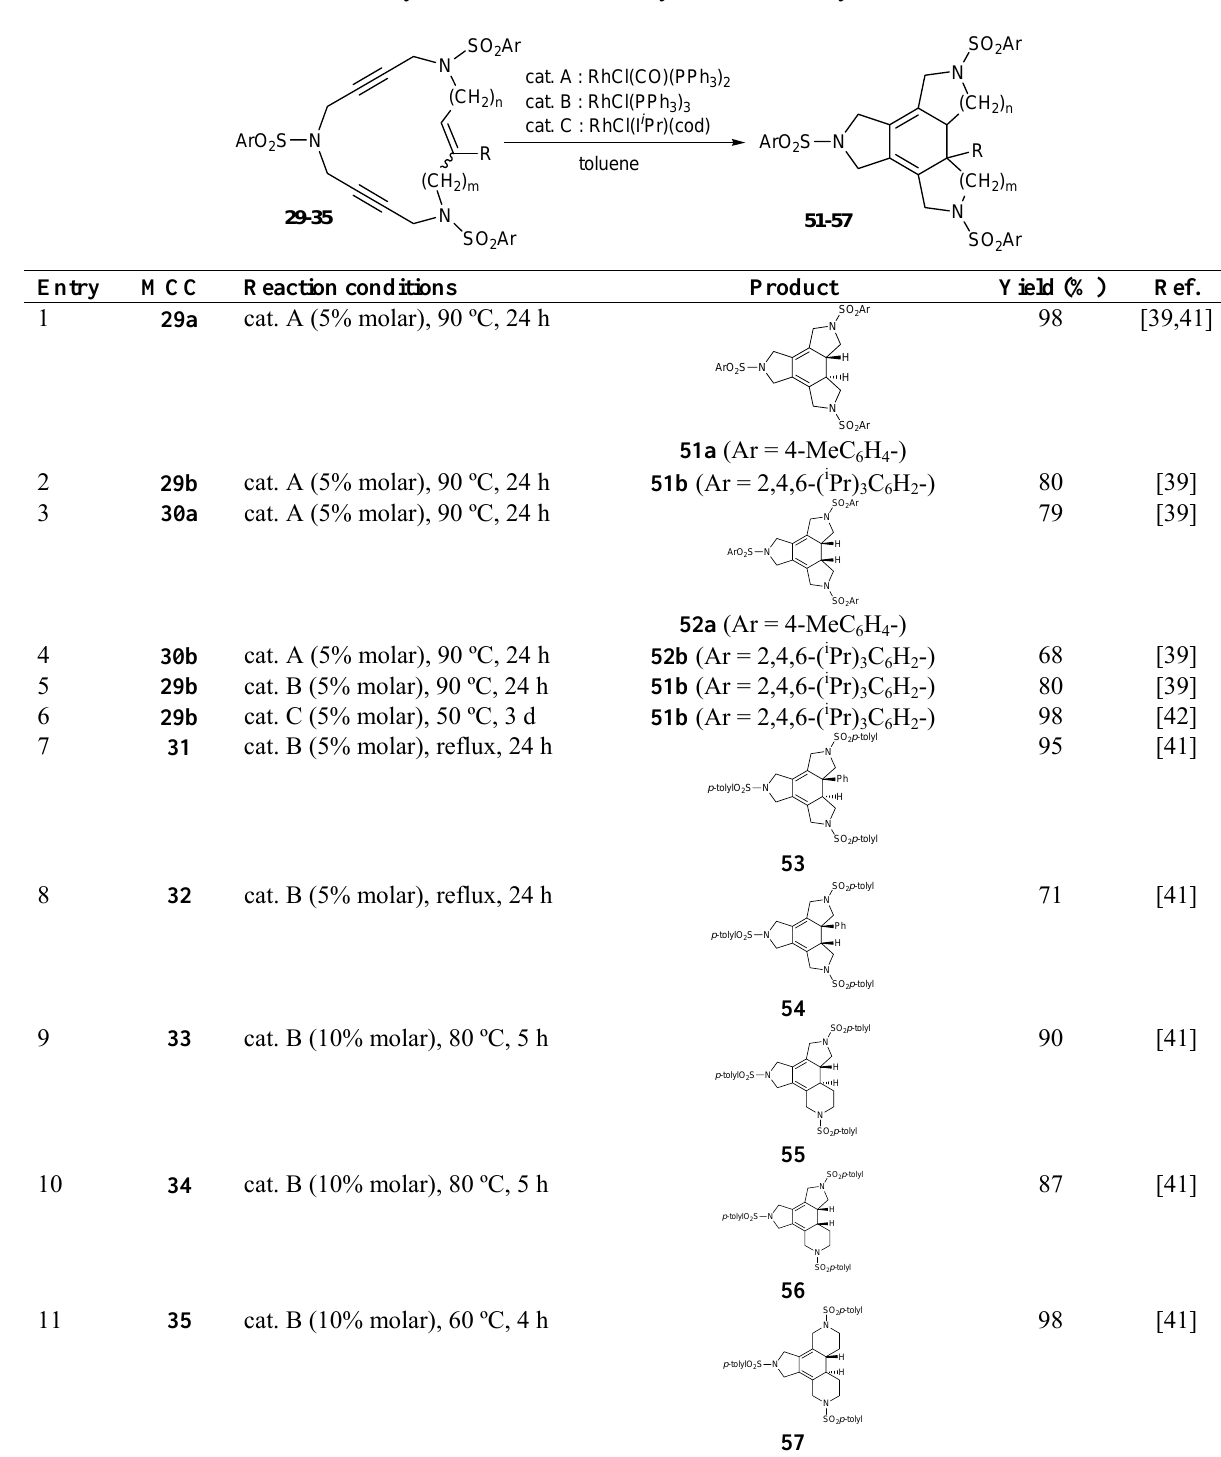
Table 3. Cycloaddition of enediyne azamacrocycles 29 - 35